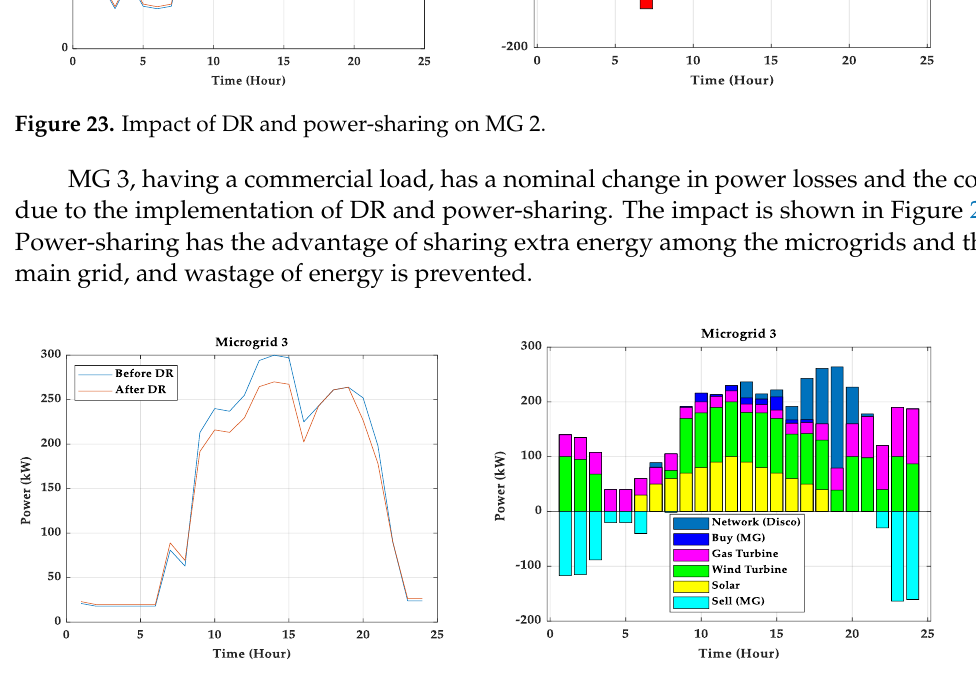
Figure 23. Impact of DR and power-sharing on MG 2.